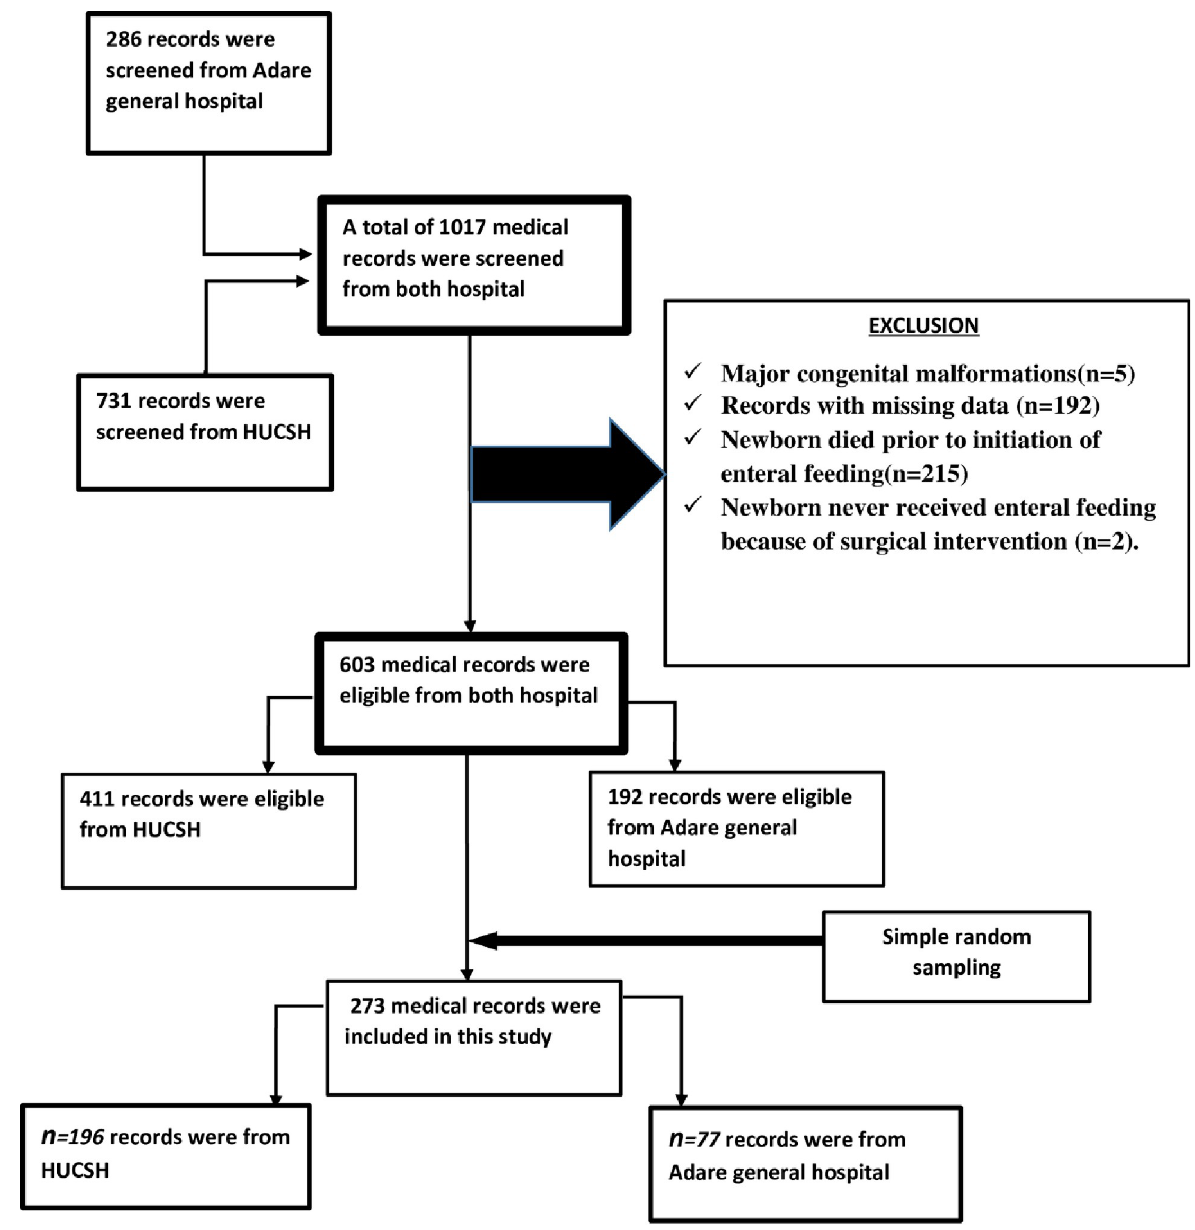
Fig 1. Schematic presentation of the sampling